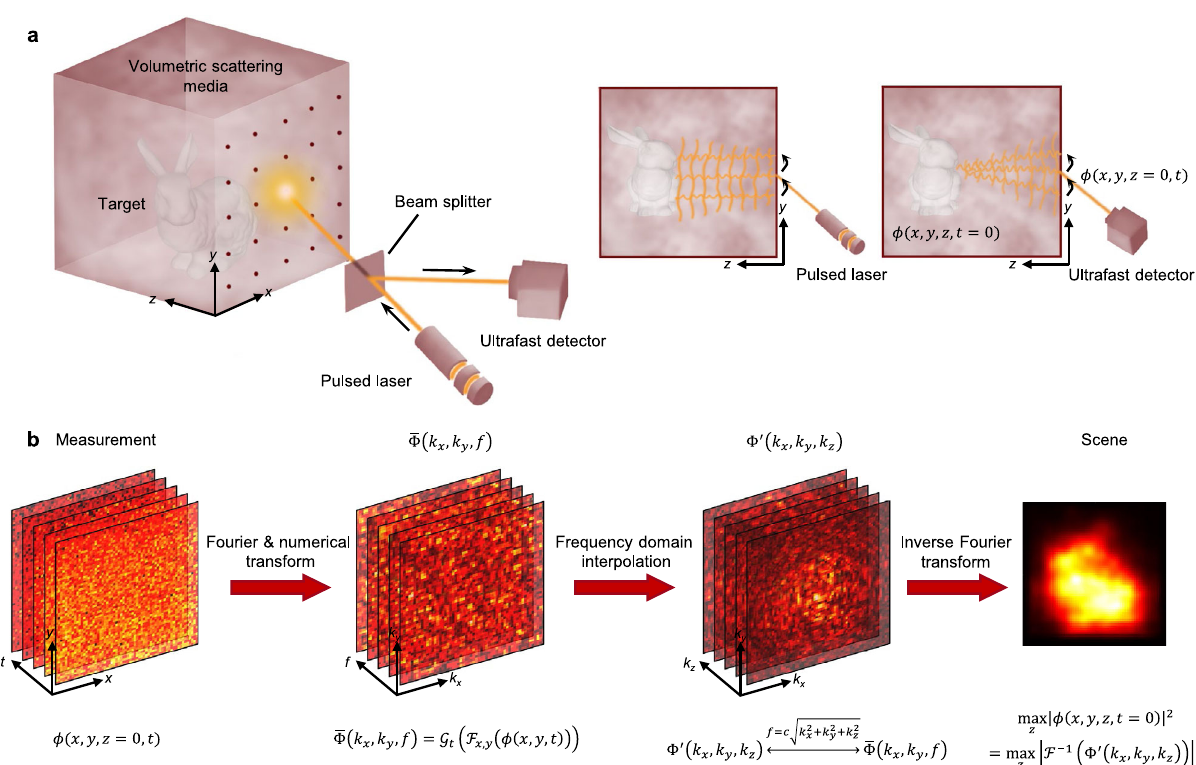
Fig. 2 Illustration of the proposed boundary migration model of the scattered fi eld. a The setup includes a pulsed laser, an ultrafast detector, a beam splitter, volumetric scattering media, and the target. Laser and detector are used to probe the time-resolved light propagation on the front surface of the scattering media. Since they share the same optical path, the light propagation in scattering media can be regarded as one-way propagation. Furthermore, supposing the target emits electromagnetic radiation at t ¼ 0, the scene information is encoded in the temporal boundary characteristics of the scattered fi eld ϕ ð x ; y ; z ; t ¼ 0 Þ . Fixing the scanning surface at z ¼ 0 ; the measurements are encoded in the spatial boundary characteristics of the scattered fi eld ϕ ð x ; y ; z ¼ 0 ; t Þ . b The entire reconstruction pipeline. Taking the measurement as the input, the proposed method follows three steps to recover the scene: Fourier and numerical transform of the measurement to get (cid:1) Φ k x ; k y ; f